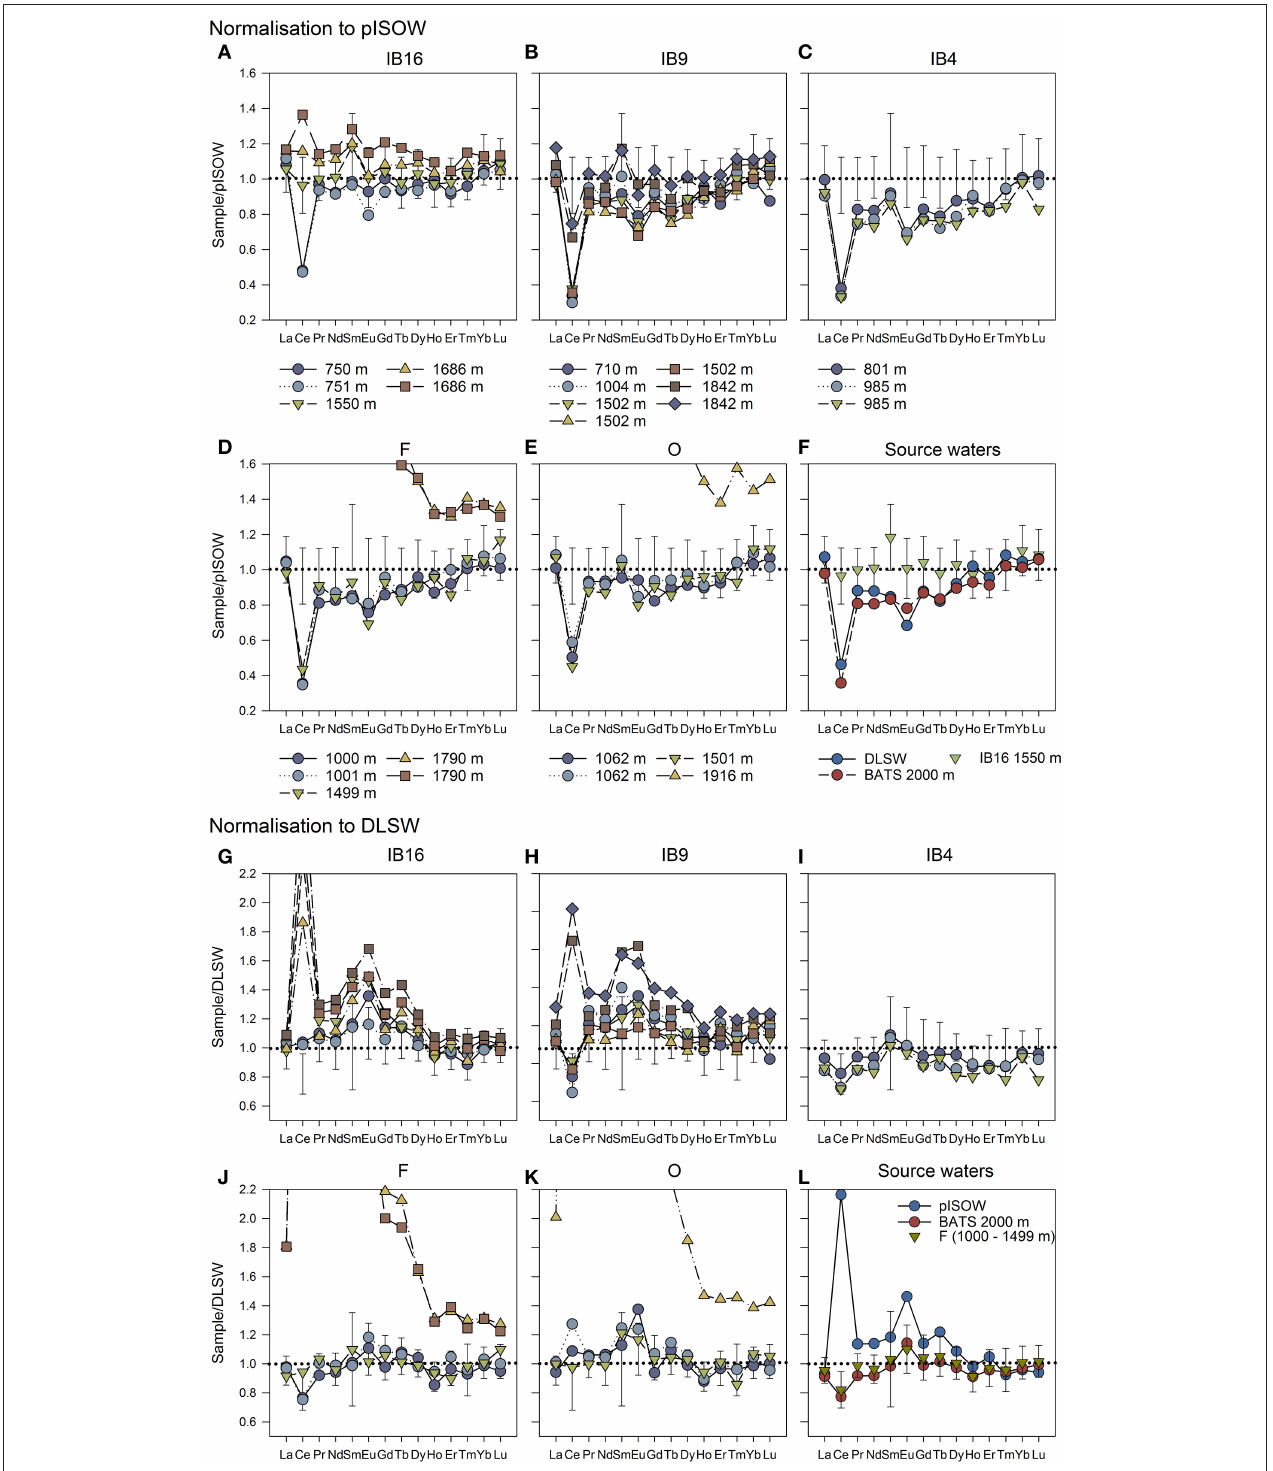
FIGURE 6 | Normalisation by pISOW of (A–E) the 5 open ocean stations along the EEL and (F) DLSW and BATS 2000m. Normalisation by DLSW of (G–K) the 5 open ocean EEL stations and (L) pISOW and BATS 2000m. The error bars shown in (A–F) represent the combined 2SD from normalisation of IB16 (1550m, shown in F ) by pISOW, and in (G–L) are based on the combined 2SD from normalisation of F (1000-1499m) by DSLW. The REE concentrations are from the literature: BATS 2000m (van de Flierdt et al., 2012), pISOW (Lacan and Jeandel, 2004b), and deep (D)LSW (Filippova et al., 2017).